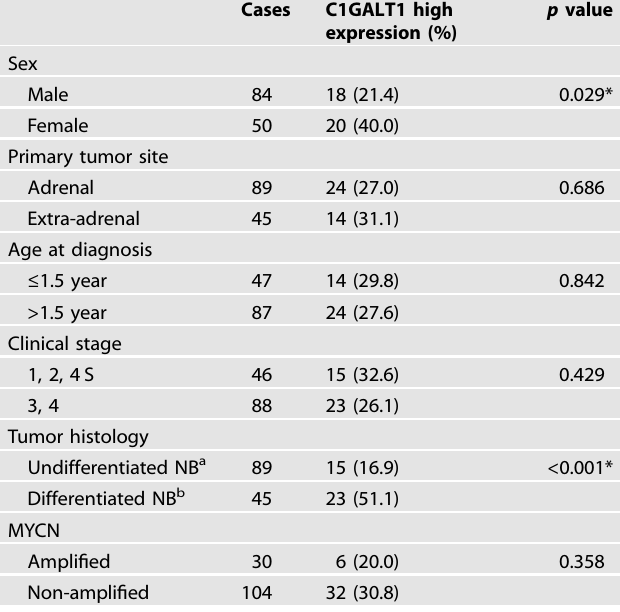
Table 1. C1GALT1 expression and clinicopathologic and biologic characteristics of